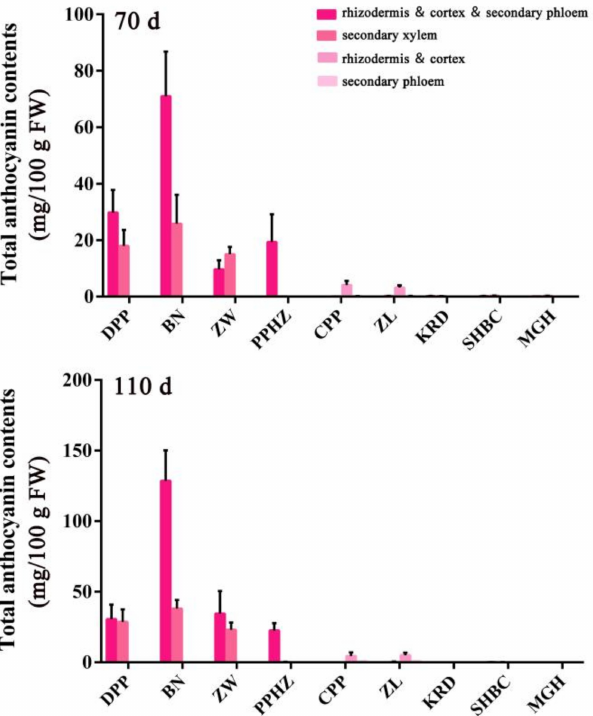
Figure 7. Total anthocyanin contents in the taproot of nine carrot cultivars at two. different stages. Error bars represent standard deviation (SD) of three replicates and are computed as cyanidin 3-O-galactoside